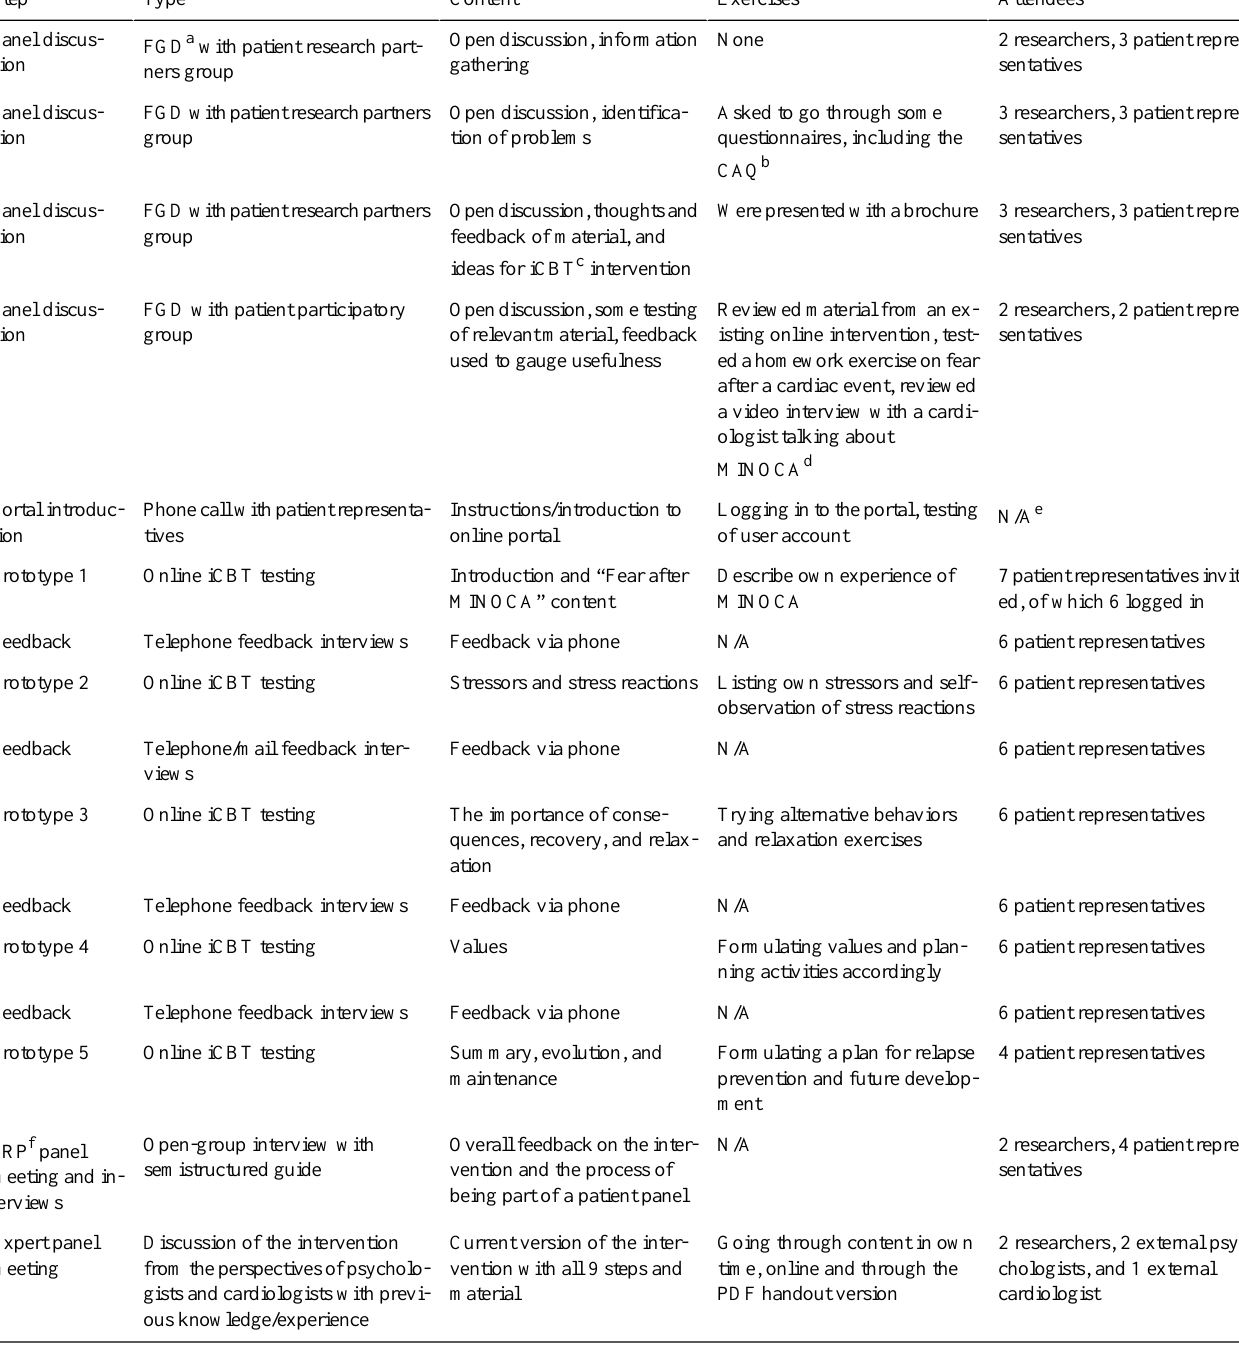
Table 1. Process stages of the development of the intervention.